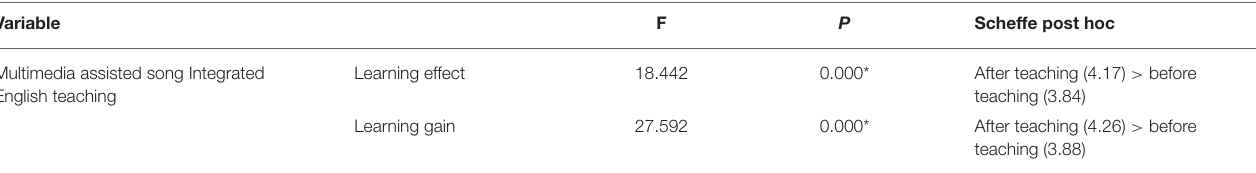
TABLE 2 | Difference analysis of multimedia assisted English song integrated English teaching in learning outcome. Variable